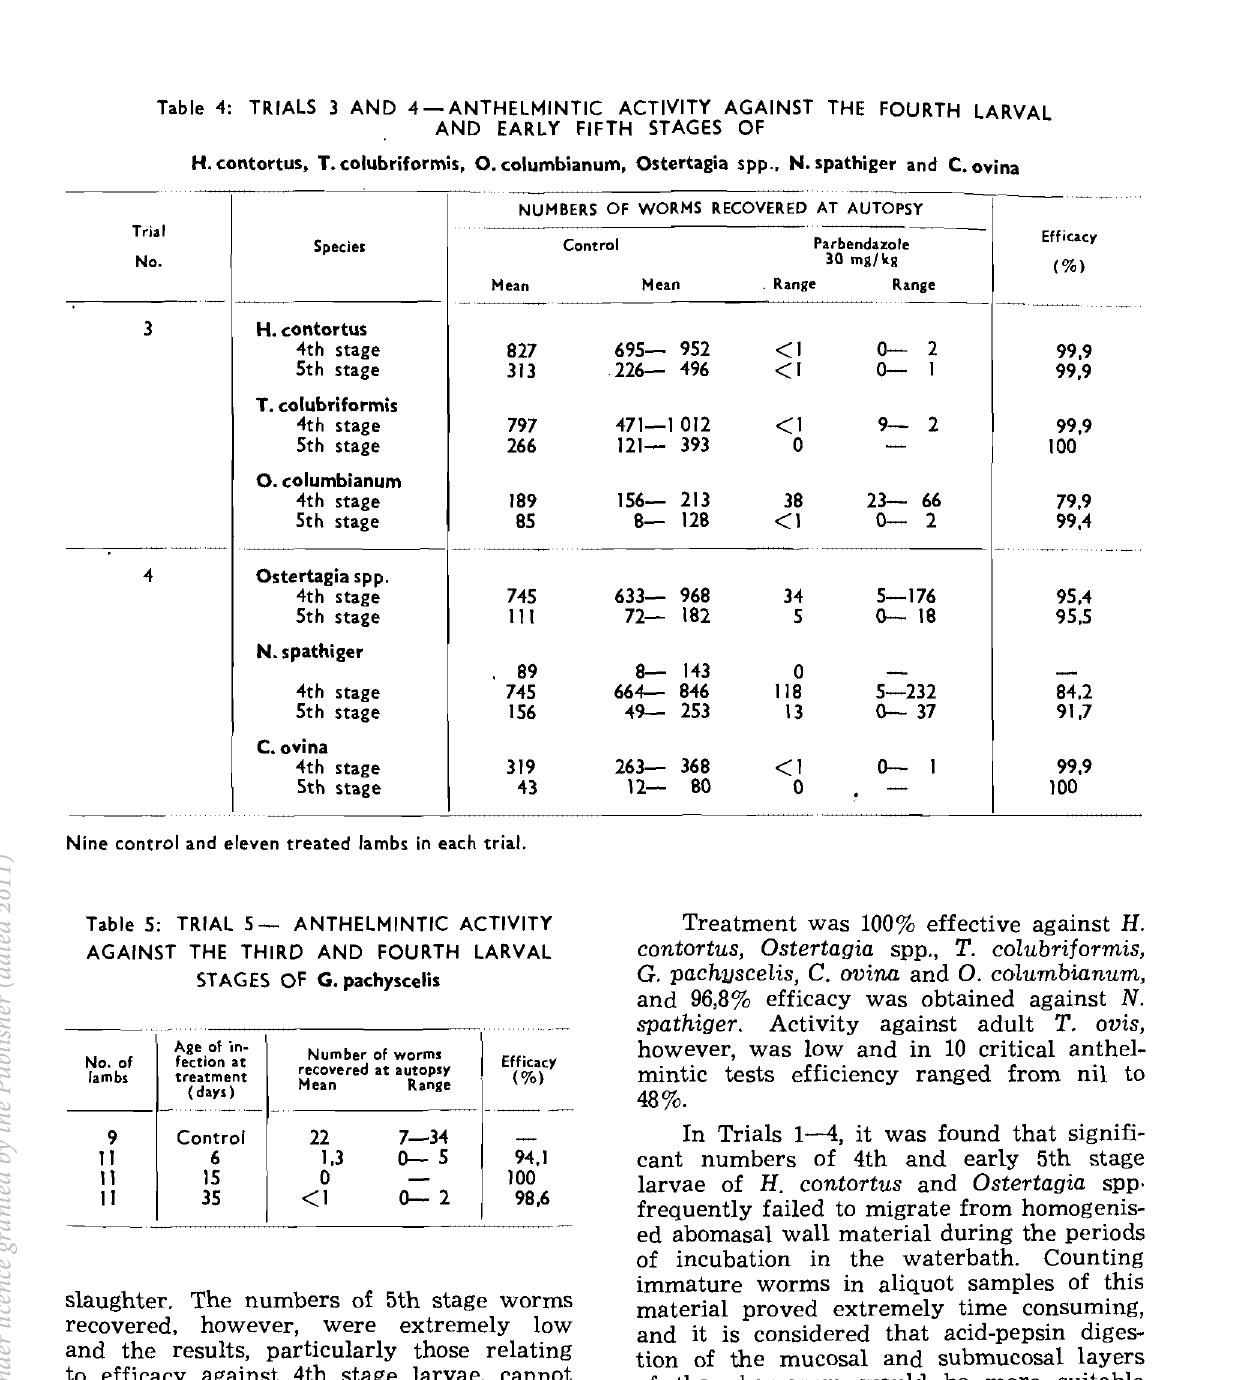
Table 5: TRIAL 5 - ANTHELMINTIC ACTIVITY AGAINST THE THIRD AND FOURTH LARVAL STAGES OF G.